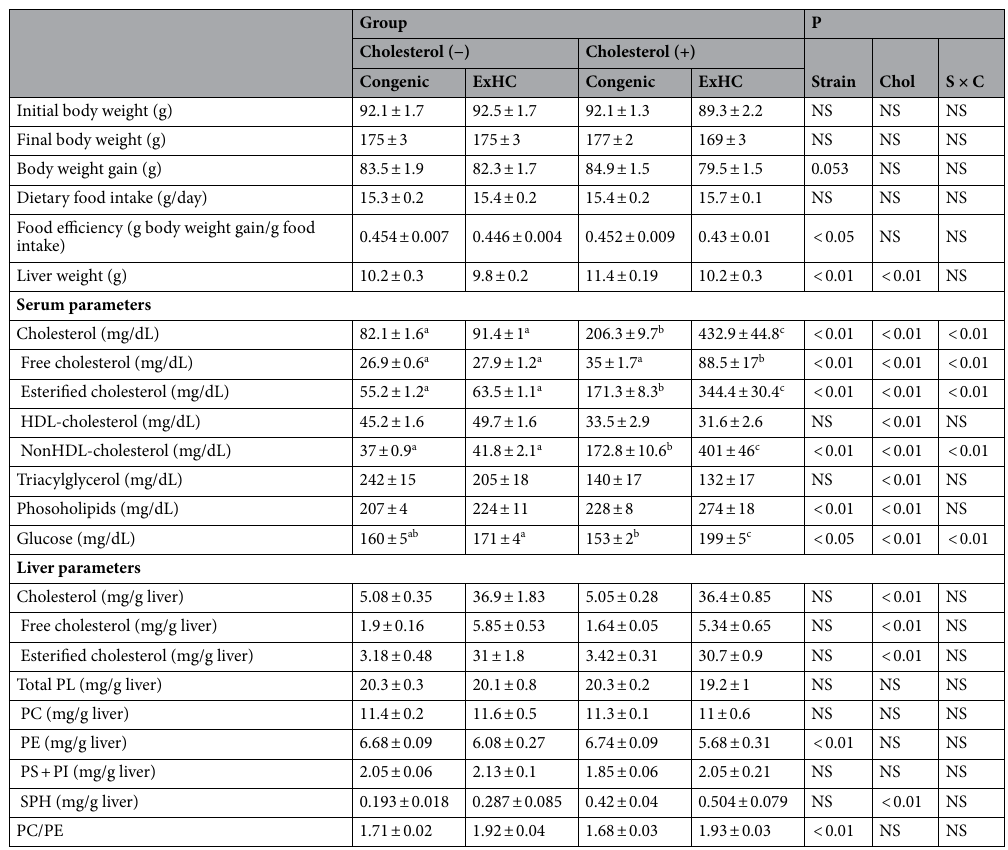
Table 1. Growth and biochemical parameters of ExHC and congenic (ExHC.BN- Dihc2 BN ) rats. Values are shown as means ± SEM. n = 6/group, Values of total PL represent the sums of PC, PE, PS + PI, and SPH. Levels of esterified and non-HDL-cholesterol were calculated as differences between total and free cholesterol level and between total cholesterol and HDL-cholesterol, respectively. Statistical differences were assessed using two-way ANOVA followed by Tukey–Kramer post-hoc tests. a,b,c Significant differences between groups with different letters at P < 0.05.